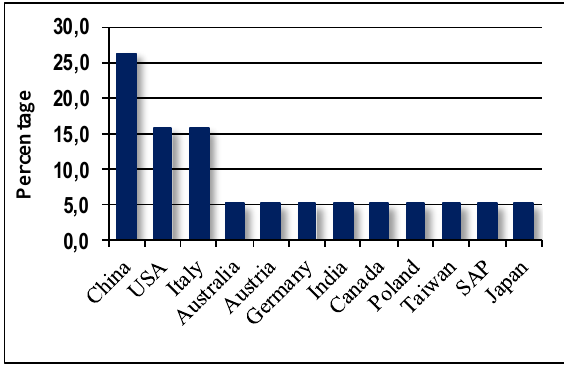
Figure 12. Countries that made major contribution in research related to web applications (2012)